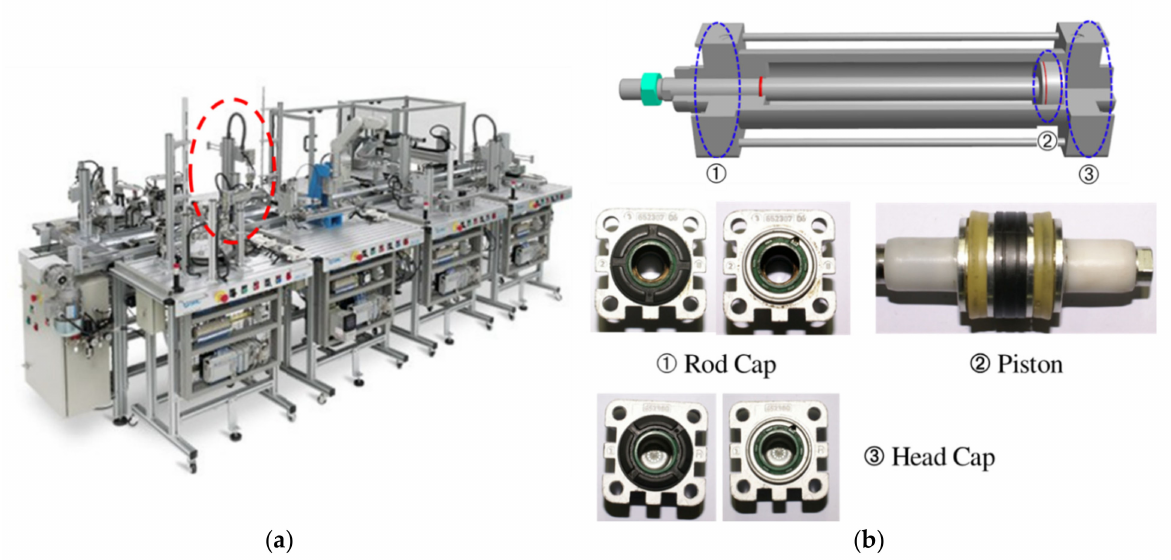
Figure 8. Pneumatic cylinder in automatic assembly line: ( a ) automatic assembly line, ( b ) main parts.